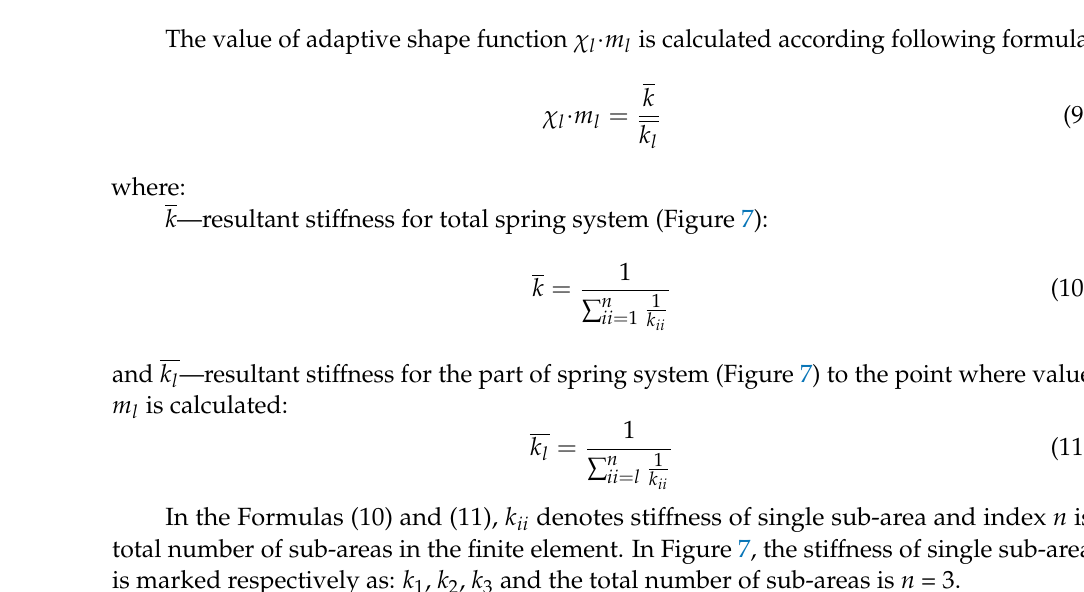
Figure 7. Modification of shape function distribution in case of integration in sub-areas—parameter χ